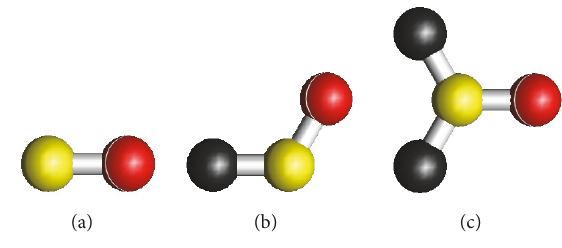
Figure 11: Three cases of atom addition.